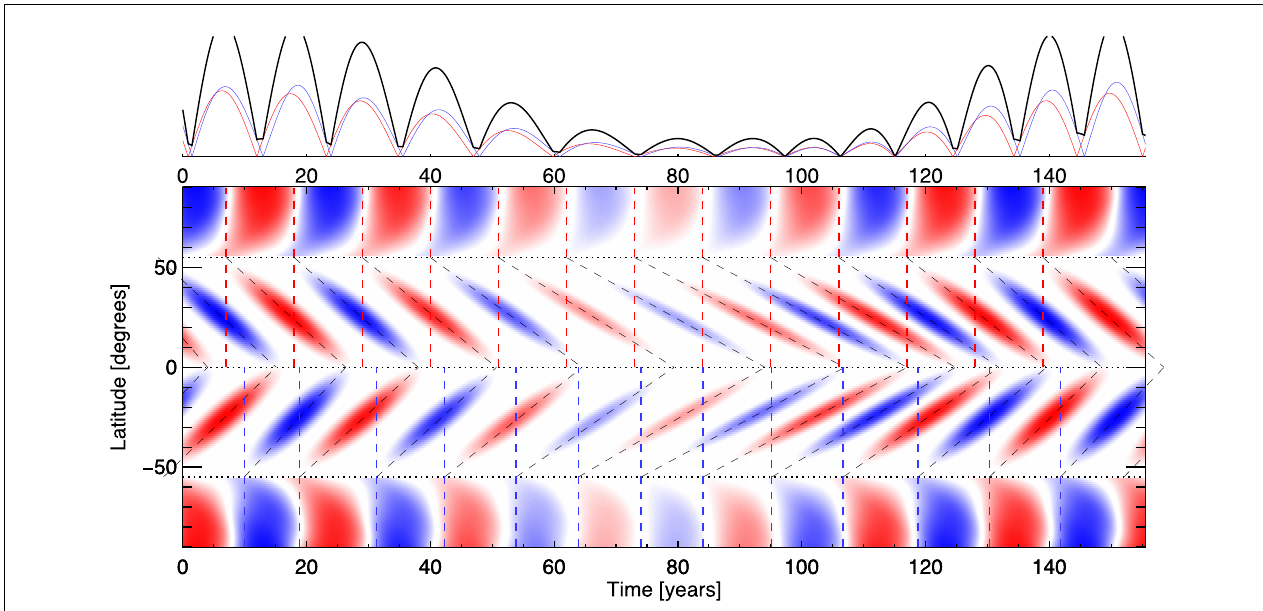
FIGURE 3 | Representing the progression of solar cycle variation into, and out of, a grand minimum state based on the simple metrics developed above. The dashed vertical lines mark the onset of the equator-ward branch in the northern (red) and southern (blue) hemisphere.